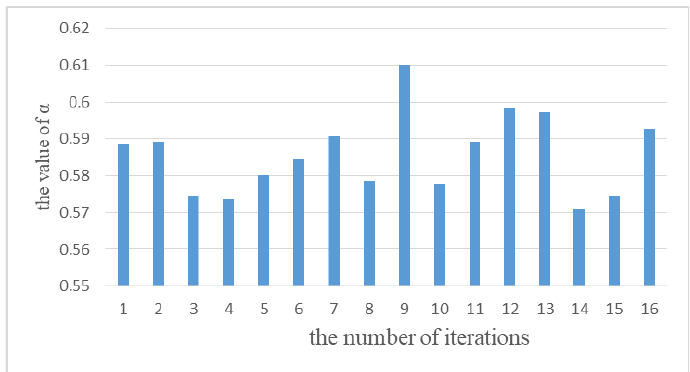
Figure 3. Self- learning weight α value changes . Figure 3. Self-learning weight α value